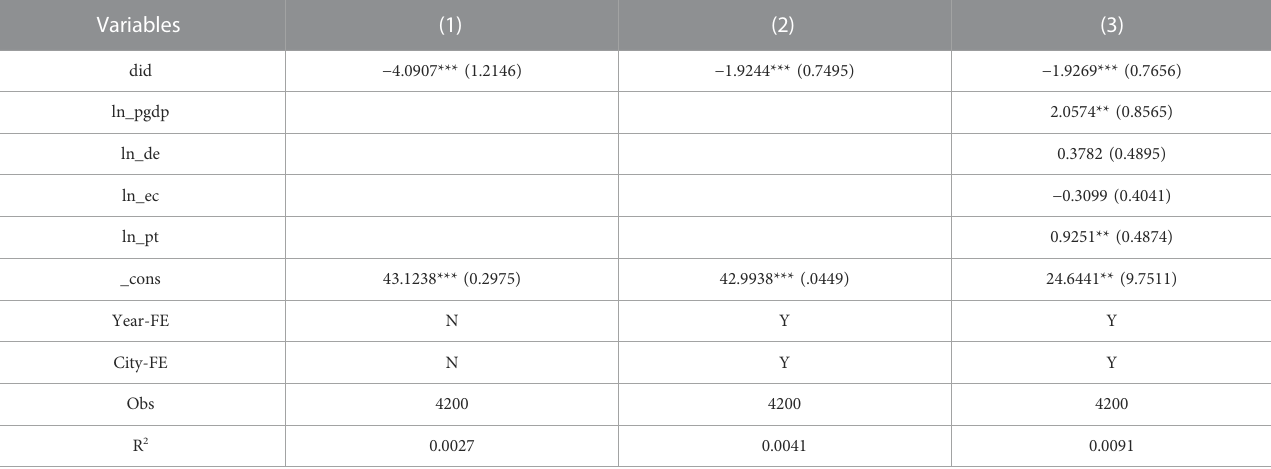
TABLE 2 The effect of NEDC policy on PM2.5: DID method.